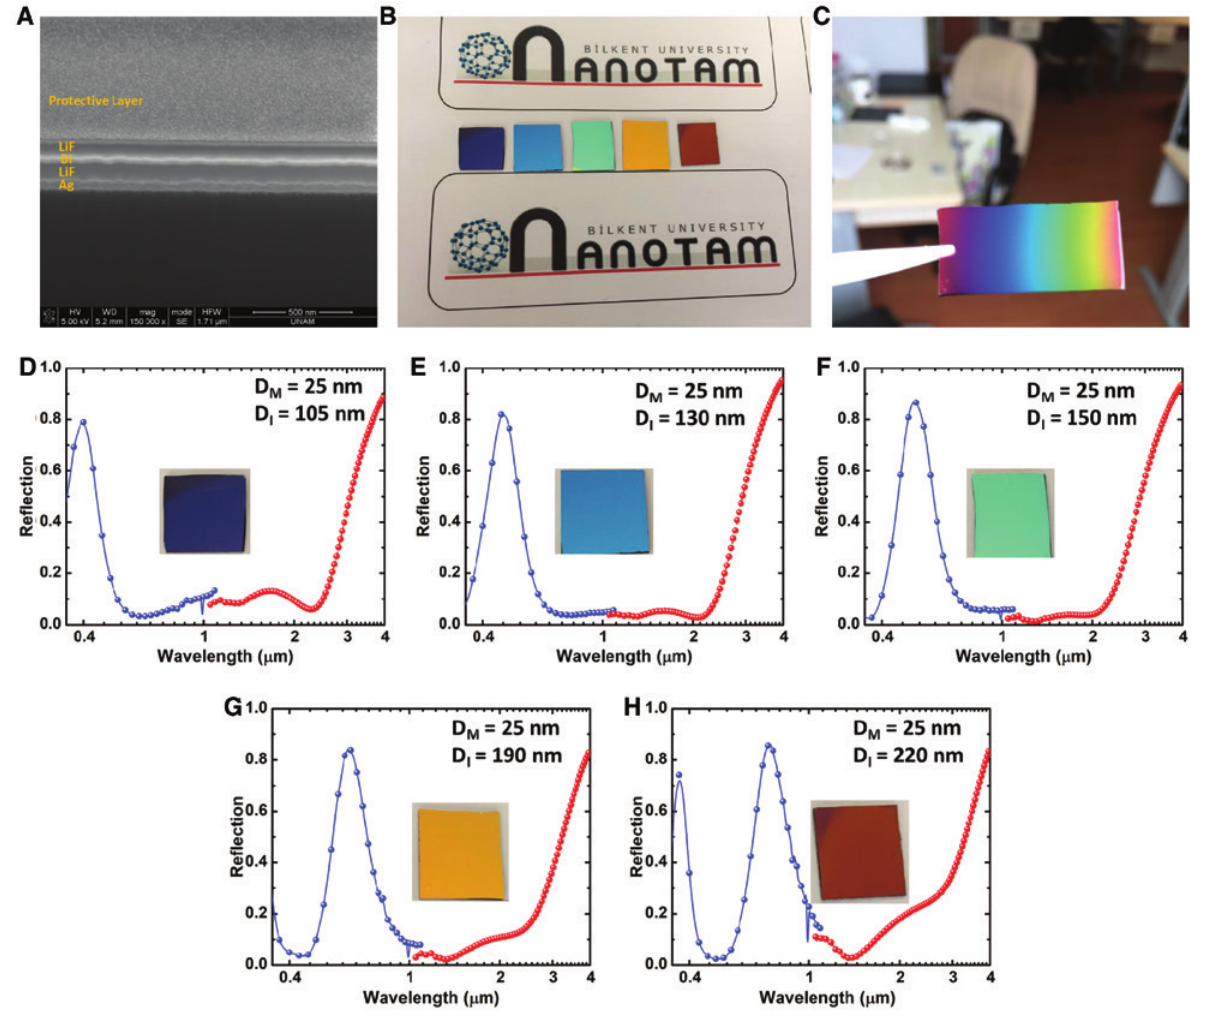
Figure 3: The measurement results for different colored MIMI cavities. (A) The cross-sectional scanning electron microscopy (SEM) image of the fabricated Ag-LiF-Bi-LiF MIMI cavity. (B) The optical images of fabricated samples with different insulator layer thicknesses of 105 nm, 130 nm, 150 nm, 190 nm, and 220 nm. Each of these thicknesses leads to generation of a specific color in the reflection mode. (C) A monolithically designed spatially variant color filter by linear variation of insulator thickness across the sample, by adjusting the geometrical parameters of the deposition system. The normal incident absorption spectra of the MIMI cavity for different D values of (D) 105 nm (blue), (E) 130 nm (cyan), (F) 150 nm (green), (G) 190 nm (orange), and (H) I 220 nm (red). In all samples, the Bi layer thickness was 25 nm, which is the optimal